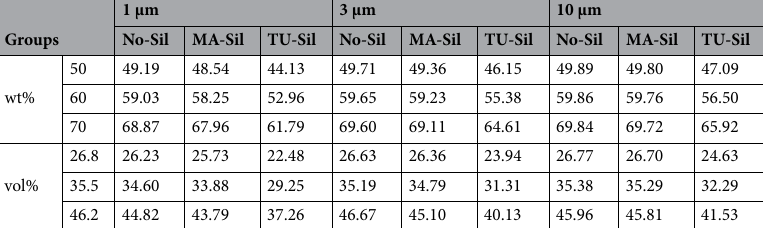
Table 5. Actual filler particles percentage by weight (wt %) and by volume (vol %) for each tested experimental composite considering the variation in filler surface coverage showed by TGA results.